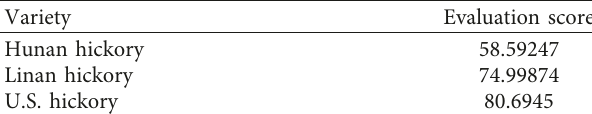
Table 3: Scores only considering